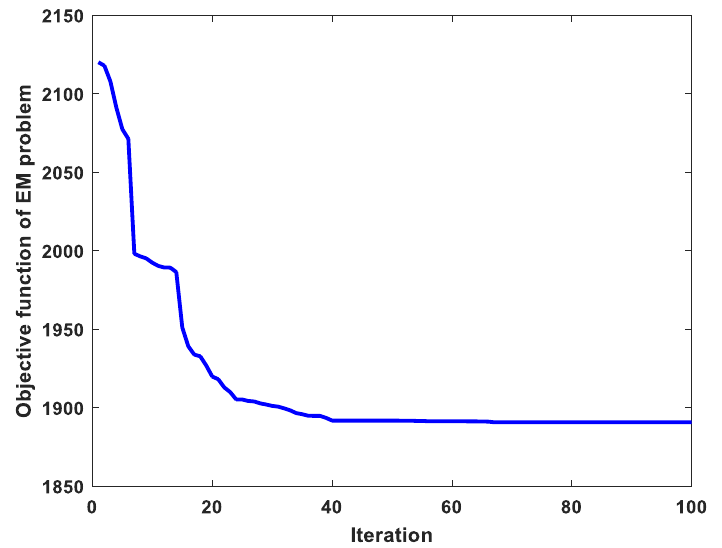
Figure 6. Convergence characteristic of the EO for Case 3. Table 12. The best results obtained using the EO for the EM problem in Case 3.